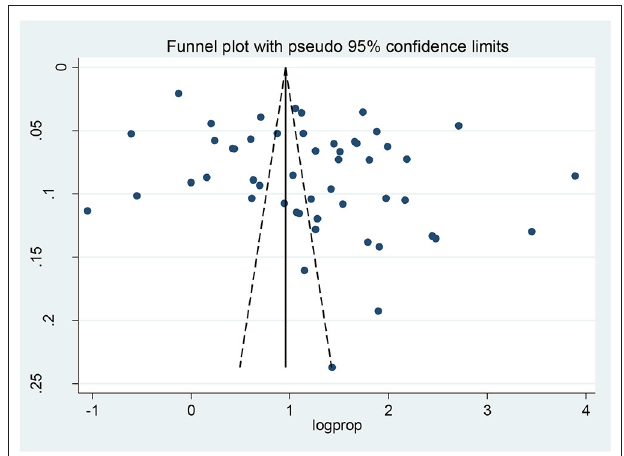
FIGURE 2 | Funnel plot to determine the presence of publication bias between 51 included studies.